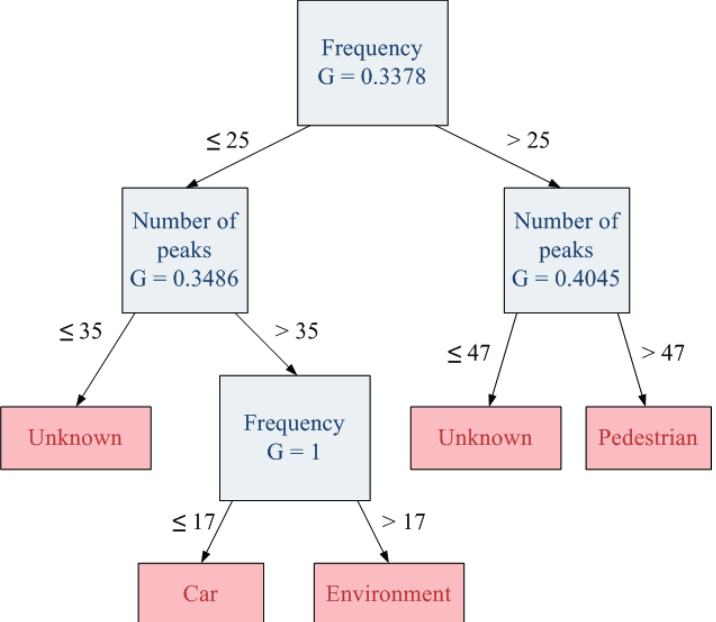
Figure 16. New decision tree